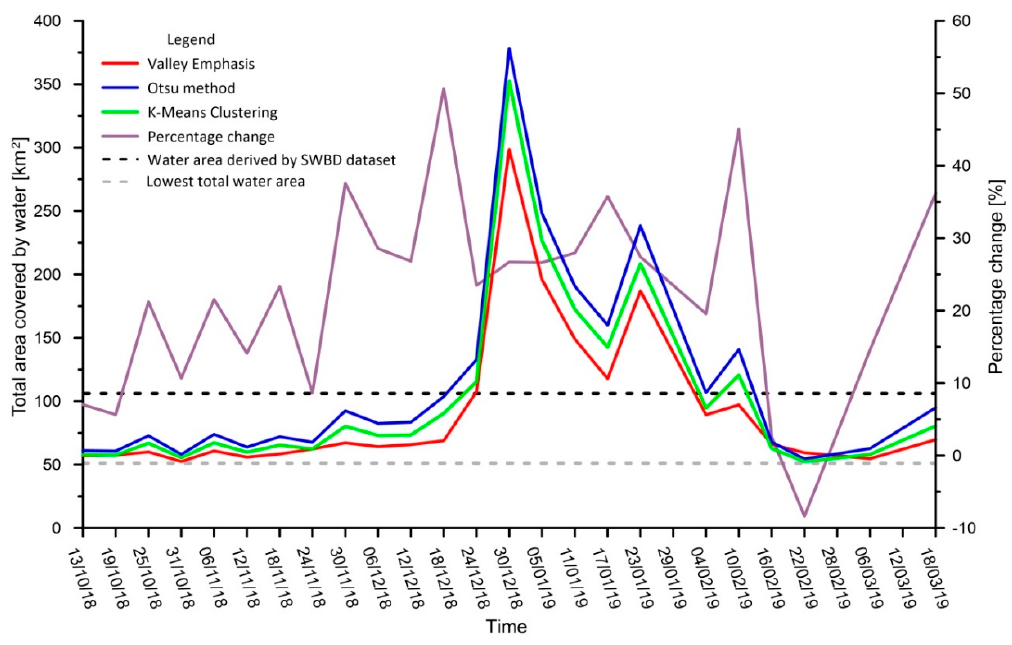
Figure 7. Graph showing the evolution of open water feature surface coverage estimated with the Valley Emphasis, Otsu, and K-Means Clustering methods (i.e., red, blue and green lines, respectively) in the study area over the monitoring period. The purple line shows the percentage difference of water area between the Valley Emphasis and Otsu methods, which show the lowest and the highest estimation value. The gray line represents the minimum value of the water area estimated by our analysis before the occurrence of the flood, and the black line represents the water area derived by the SWBD dataset.